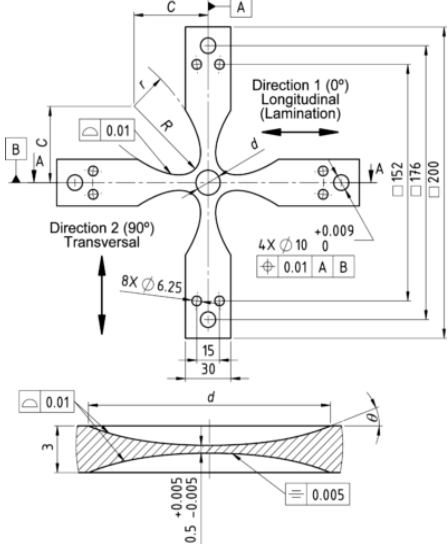
Figure 12. Cruciform specimen studied by Claudio et al. [2,78].